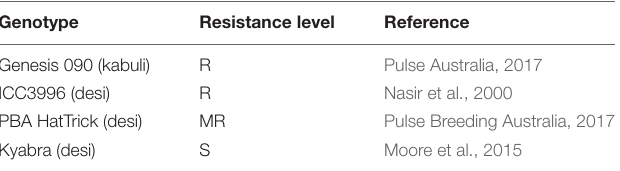
TABLE 1 | Differential host genotypes and their known disease response ratings to A. rabiei in Australia. Genotype